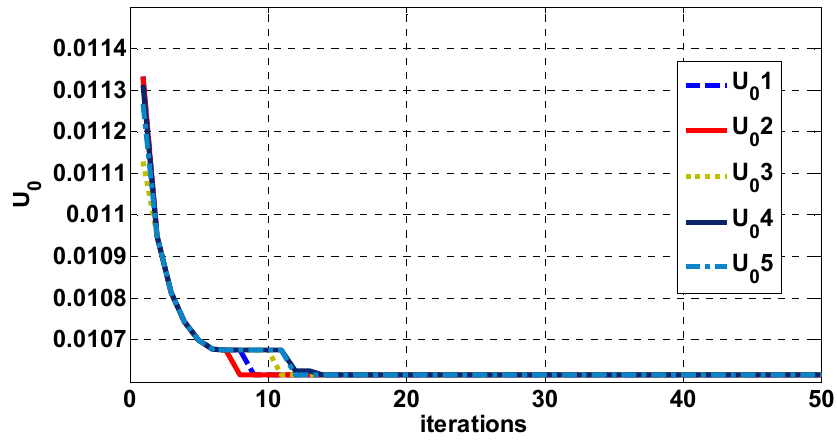
Figure 3. U convergence curve using (cid:2868)